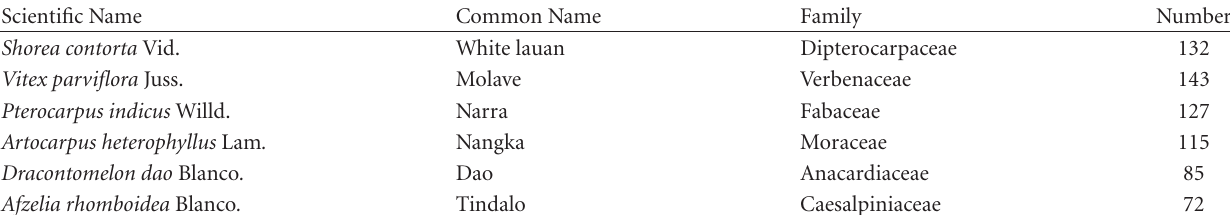
Table 2: Total number of trees measured for each species found in Manlawan.